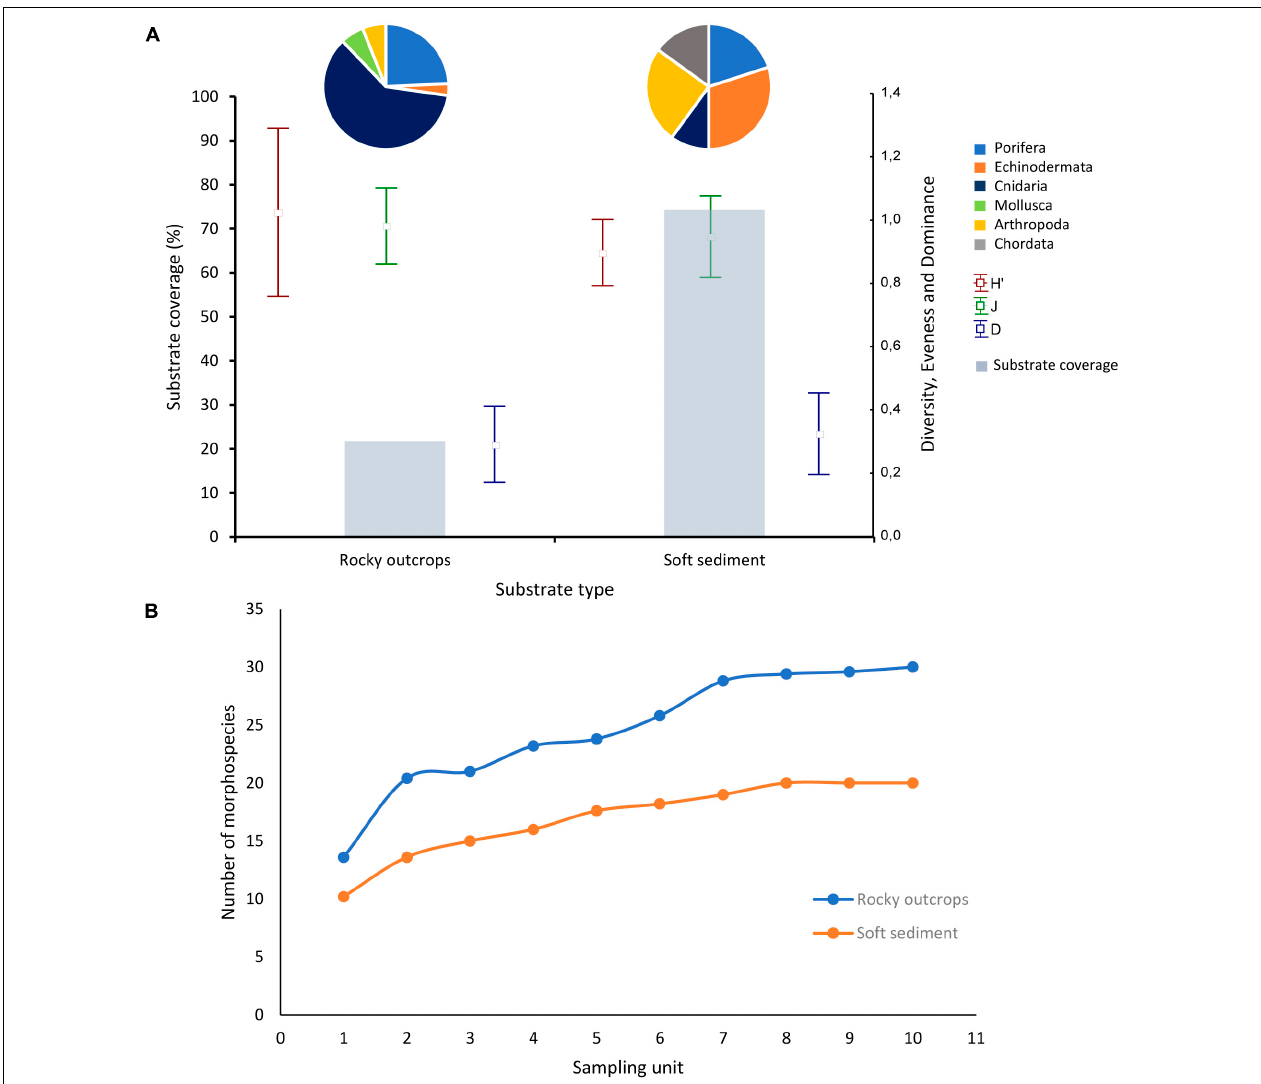
FIGURE 2 | (A) Composition, proportional taxonomic richness and mean diversity indices by substrate type percent coverage. Pie graphs represent percent taxonomic richness contribution by phylum in each substrate type. Dots denote means of descriptors H (cid:48) = Shannon-Wiener diversity index; J = evenness index; D = dominance index. Vertical bars denote ± standard deviation. Bar graph represent substrate type percent coverage. (B) Rarefaction plots corresponding to the megafaunal assemblages on soft sediment and rocky